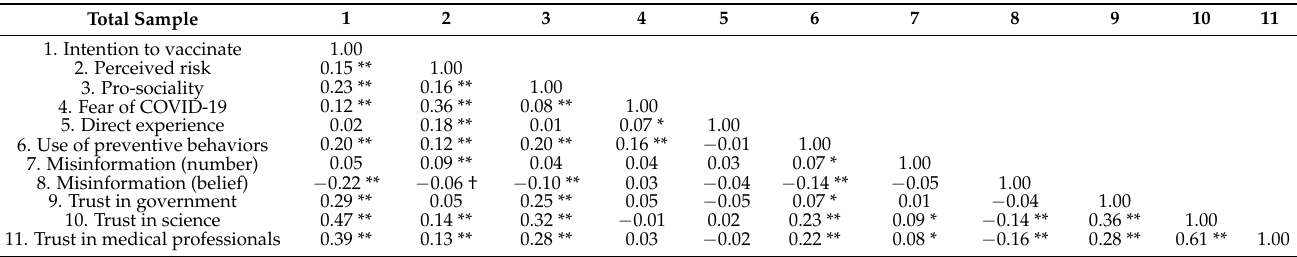
Table 4. Pearson’s correlations between all variables ( N =